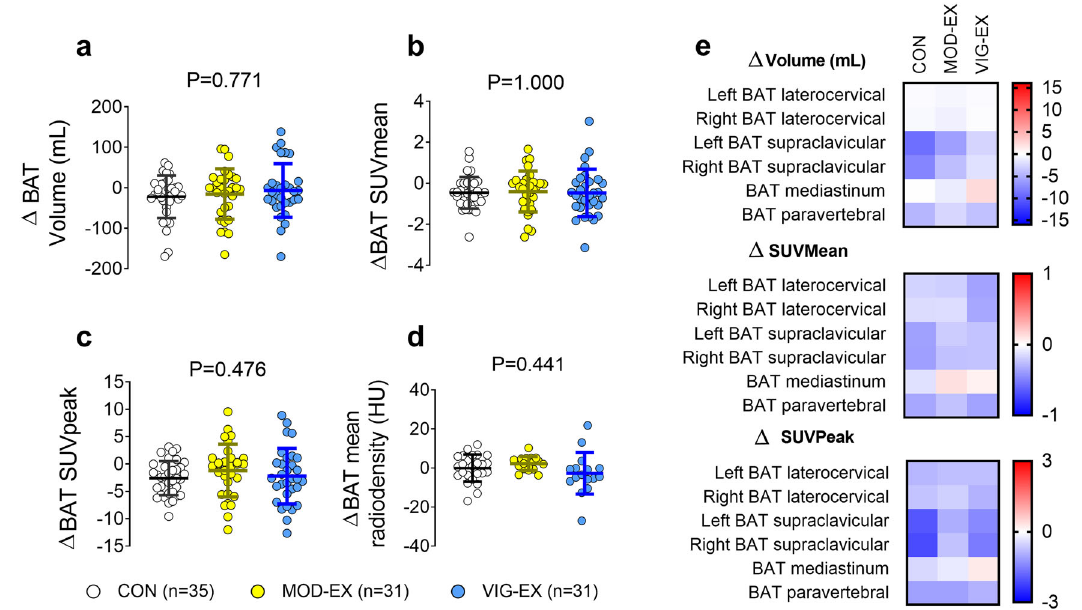
Fig. 2 | Effect of the 24-week supervised exercise intervention on brown adi- pose tissue (BAT) volume, 18 F- fl uorodeoxyglucose ( 18 F-FDG) uptake (Standar- dizeduptakeValue[SUV]meanandpeak),andmeanradiodensity.a TotalBAT volume. b Total BAT SUVmean. c Total BAT SUVpeak. d Total BAT mean radio- density (CON n =25; MOD-EX n =17; VIG-EX n =16). E Regional BAT volume, SUV- mean, and SUVpeak. SUV values are shown relative to lean mass. Δ was calculated